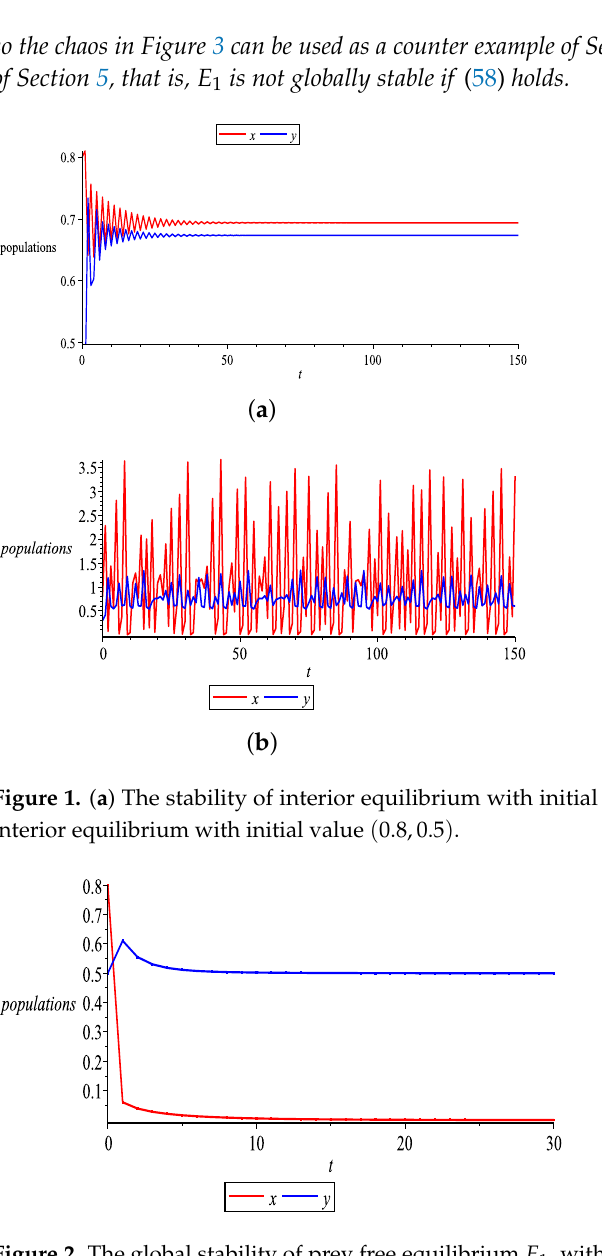
Figure 2. The global stability of prey free equilibrium E 1 , with the initial values ( 0.8,0.5 ) .